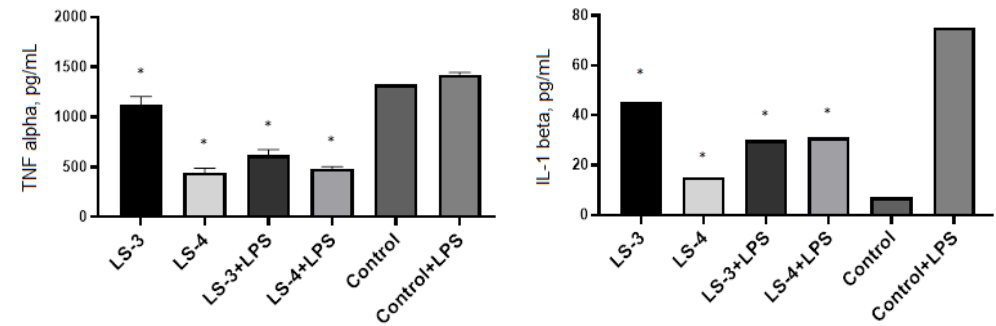
Figure 8. Effects of S. sclarea L. extracts on the secretion of TNF- α and IL-1 β by murine peritoneal macrophages. (LS-3)—sage extract obtained by conventional extraction and (LS-4)—sage extract obtained by ultrasonic-assisted extraction. Two controls were used in the experiment: macrophages without treatment or stimulus and macrophages activated with LPS. (*) indicates significant differences in comparison to control, p < 0.05.